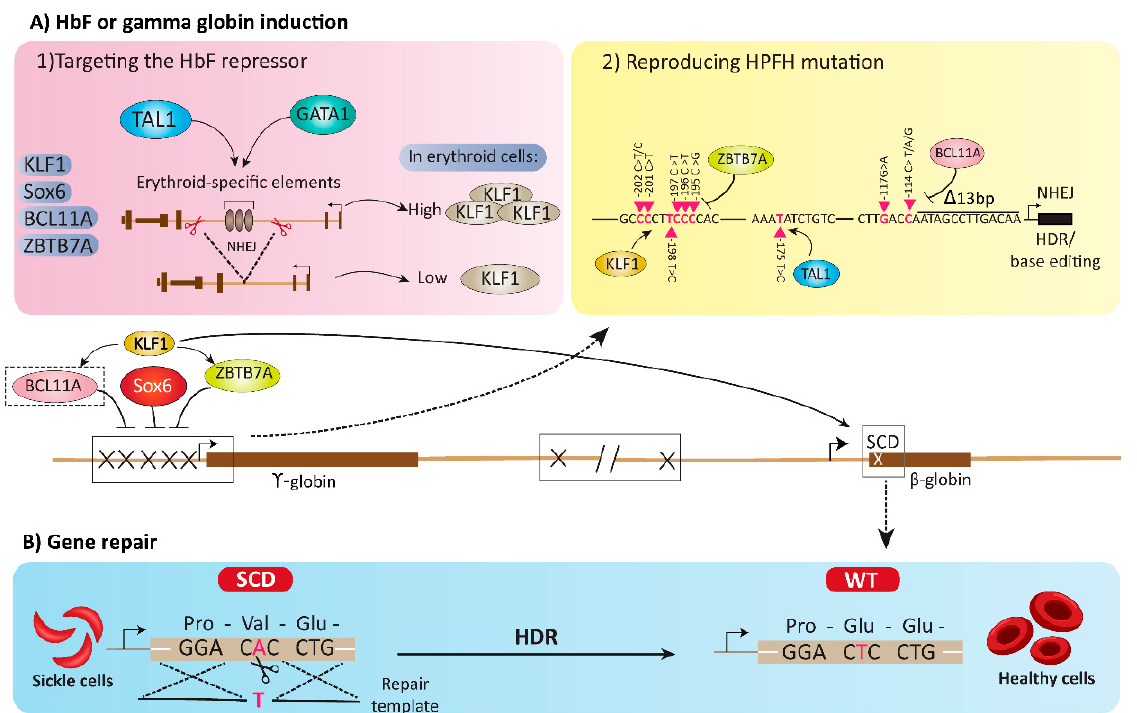
Figure 4. Molecular mechanism of β -globin repair in beta-hemoglobinopathies patients by genome editing tools. In adults, BCL11A, SOX6 and ZBTB7A via binding to the proximal promoter of the γ - globin gene cause it to repress, and KLF1 activated their expression to inhibit expression of γ -globin gene. Moreover, KLF1 as an activator, upregulates β -globin through direct binding to its promoter. ( A ) HbF upregulate by: (1) targeting erythroid–specific elements in the KLF1 , SOX6 , BCL11A and ZBTB7A gene, their expression is attenuated; and (2) creating a point mutation mimicking hereditary persistence of fetal hemoglobin (HPFH) phenotype via targeting the binding sites of BCL11A and ZBTB7A transcription factors in the γ - globin gene promoter. ( B ) The last mechanism is point mutation repair of the β -globin gene in patients with sickle cell disease or β -thalassemia and return to wild-type by homology-directed repair